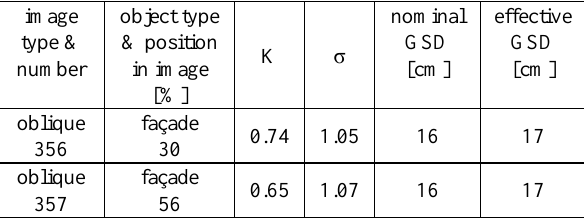
Table 1. Results of edge analysis in RCD30 Oblique images